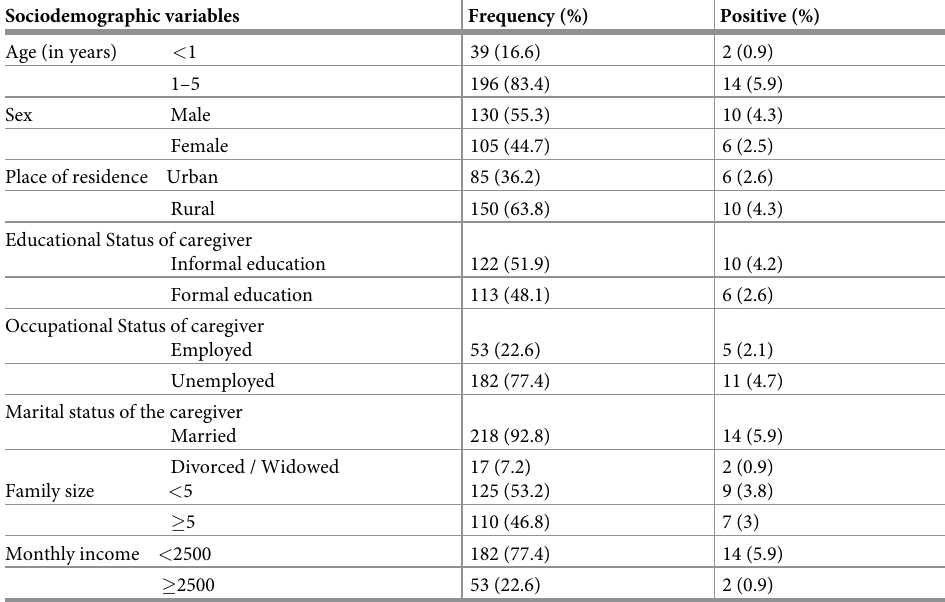
Table 1. Socio-demographic and economic characteristics of the participants at governmental hospitals in Hawassa city, Sidama, Ethiopia,